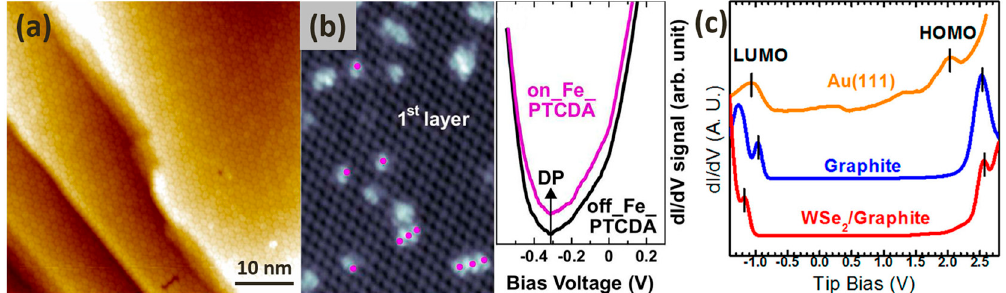
Figure 7. PTCDA on layered substrates. ( a ) Molecularly-resolved STM image of one monolayer PTCDA covered epitaxial G on SiC(0001). ( b ) STM image of ~0.01 ML Fe (protrusions) on one monolayer PTCDA covered Bi2Se3 ( left ) and STS curves at positions with/without Fe (purple/black, right ). ( c ) STS curves at positions of PTCDA on Au(111), graphite, and WSe2/graphite. Panel a printed